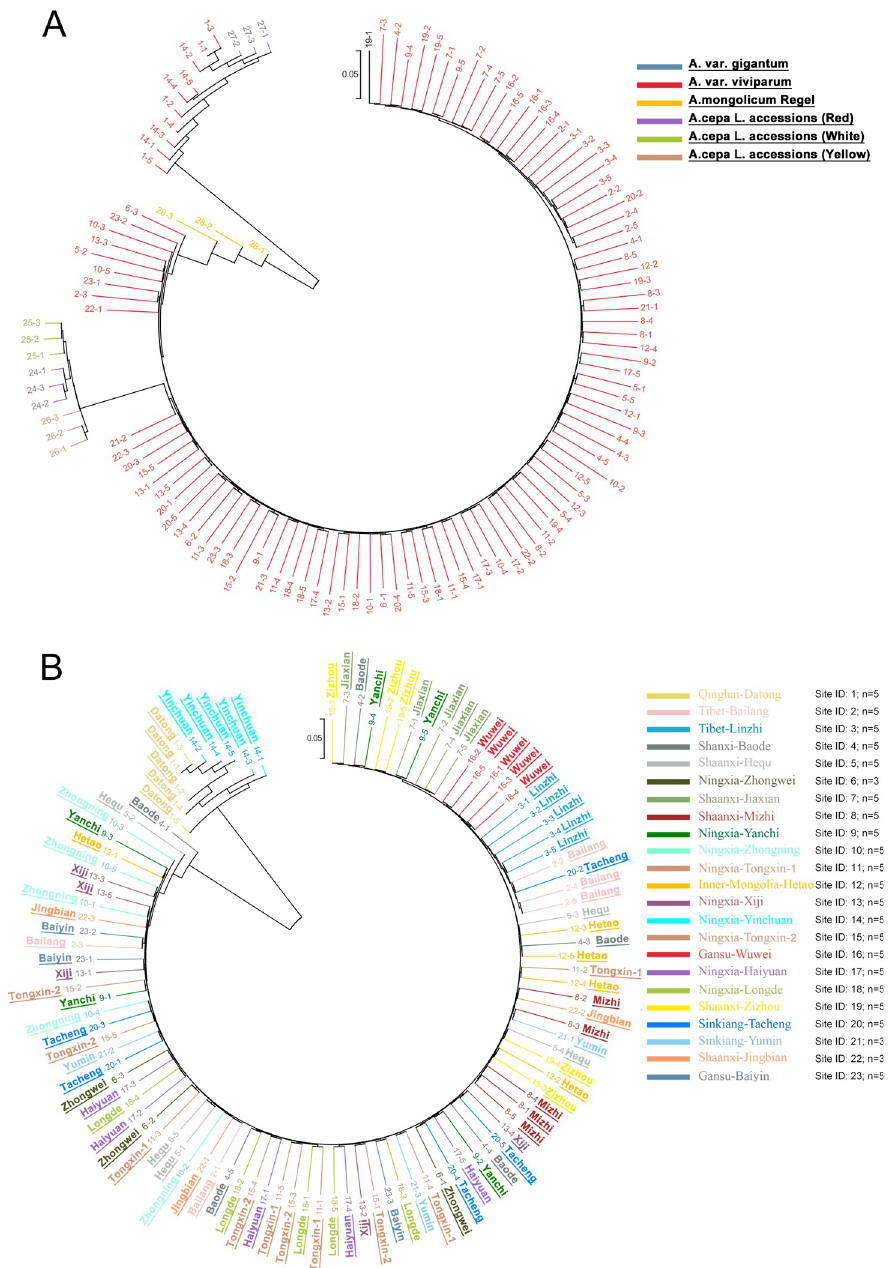
Fig 3. The phylogenetic evolution tree of the all accessions. A. the phylogenetic evolution tree of the 122 sequencing accessions. Different label colors represent different varieties. B, the phylogenetic evolution tree of the 107 A . fistulosum L. var. viviparum Makino accessions from 23 different sites, respectively. Different colors indicate different sampling locations. The accessions are noted by different numbers as shown in Table 1. mongolicum Regel accessions and A . cepa L. had long genetic distance from A . fistulosum L. var. viviparum Makino, which indicated the A . fistulosum L. var. viviparum Makino had later diver- gence time. Interestingly, the A . fistulosum L. var. viviparum Makino from Datong and Yin- chuan were clustered together with A . fistulosum L. var. gigantum Makino, which showed that